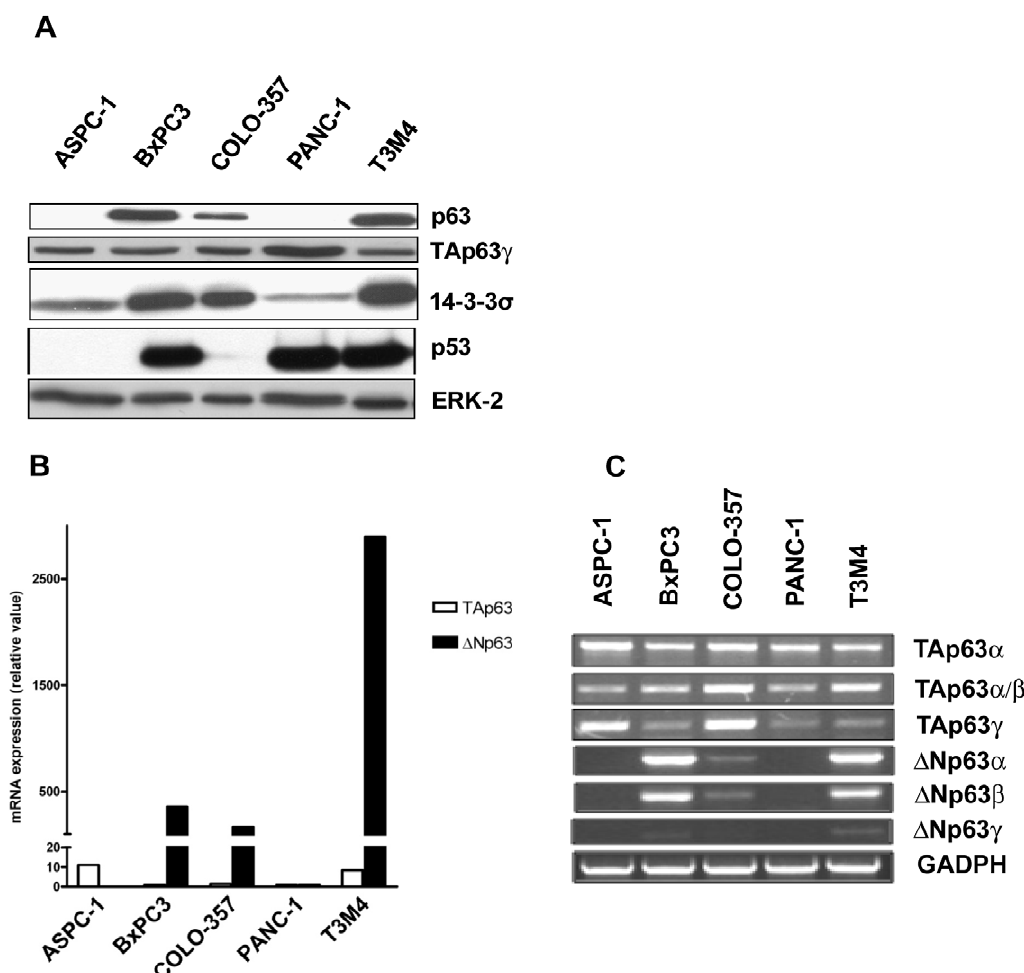
Figure 1. Expression of 14-3-3 s , p63 isoforms and p53 in pancreatic cancer cell lines. A , Protein levels of p63, 14-3-3 s , TAp63 c and p53 in pancreatic cancer cell lines. B , mRNA expression of TAp63 and D Np63 isoforms of p63 in pancreatic cancer cell lines. Total RNA isolated from PDAC cell lines was reverse-transcribed and subjected to real-time PCR with probes specific for D N and TA isoforms of p63. Results were normalized to 18S levels, and expressed as mean of two independent experiments done in duplicates in which similar results were obtained. C , mRNA expression of p63 splicing variants in pancreatic cancer cell lines. Levels were normalized to glyceraldehyde-3-phosphate dehydrogenase (GAPDH) values.